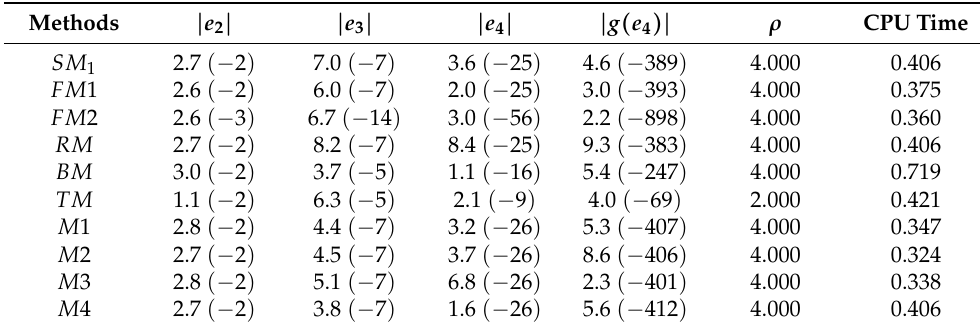
Table 2. The outcomes of Example 2 based on various